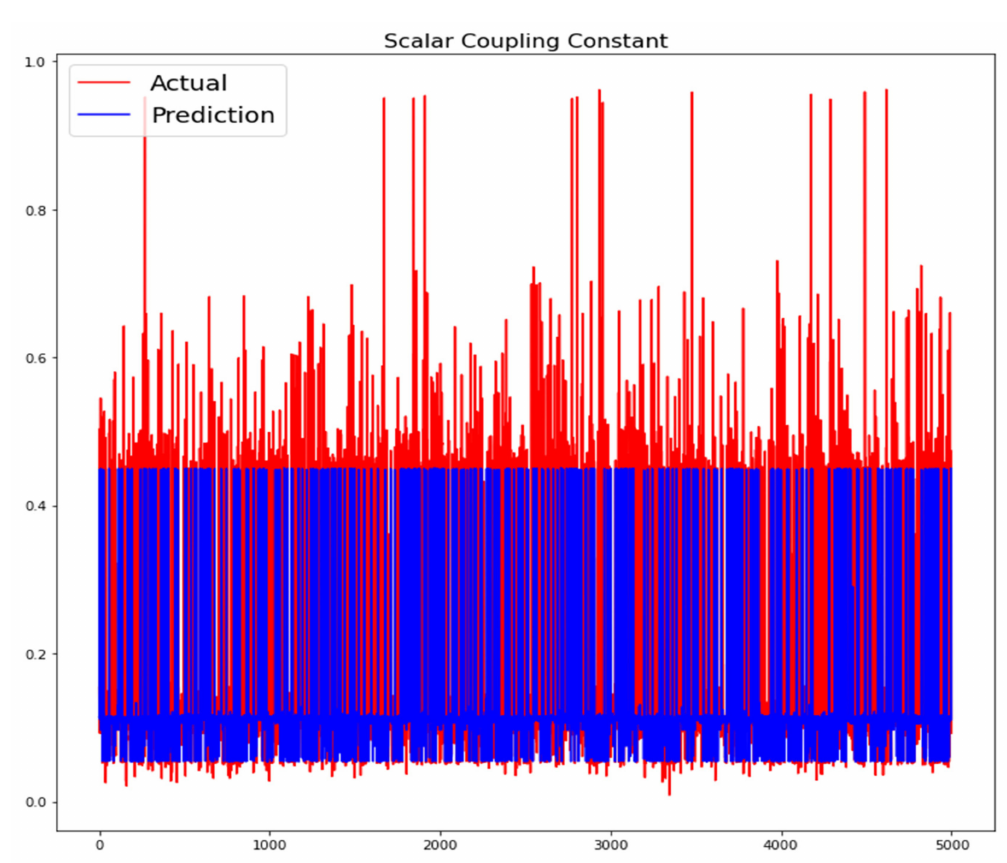
Figure 15. Actual and prediction values of